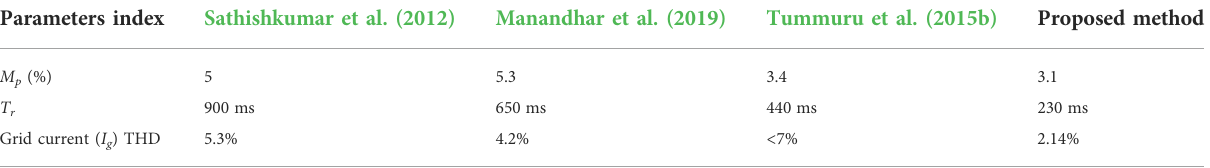
TABLE 5 Comparative analysis of the proposed system with existing methods. Parameters